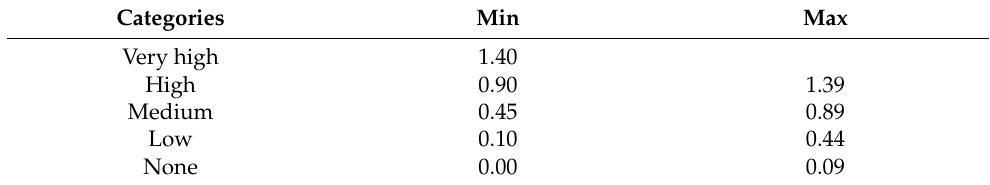
Table 5. Seismic risk categories and values.